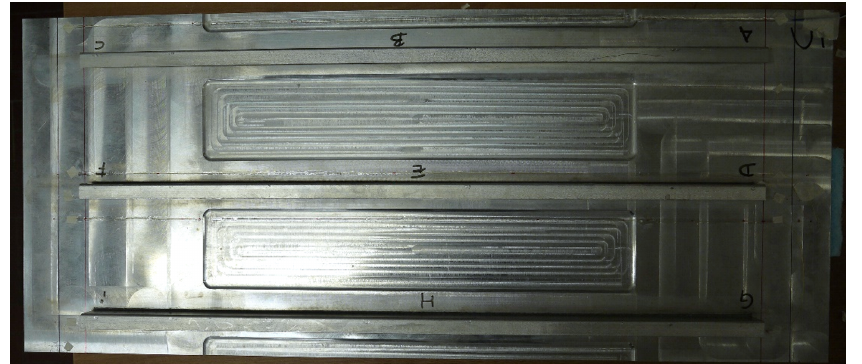
Figure 1. Top view of the stiffened